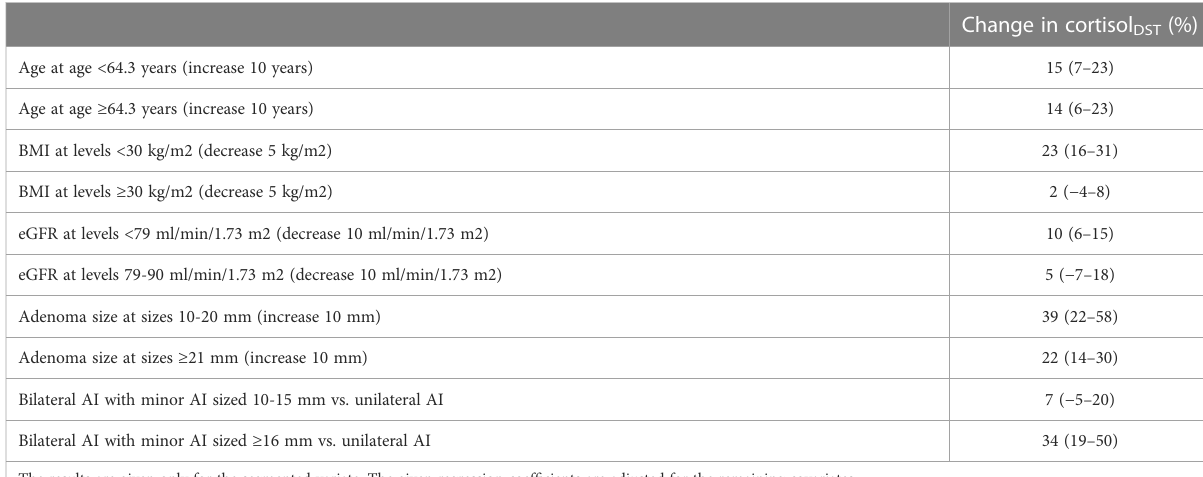
Table 4 Results from segmented